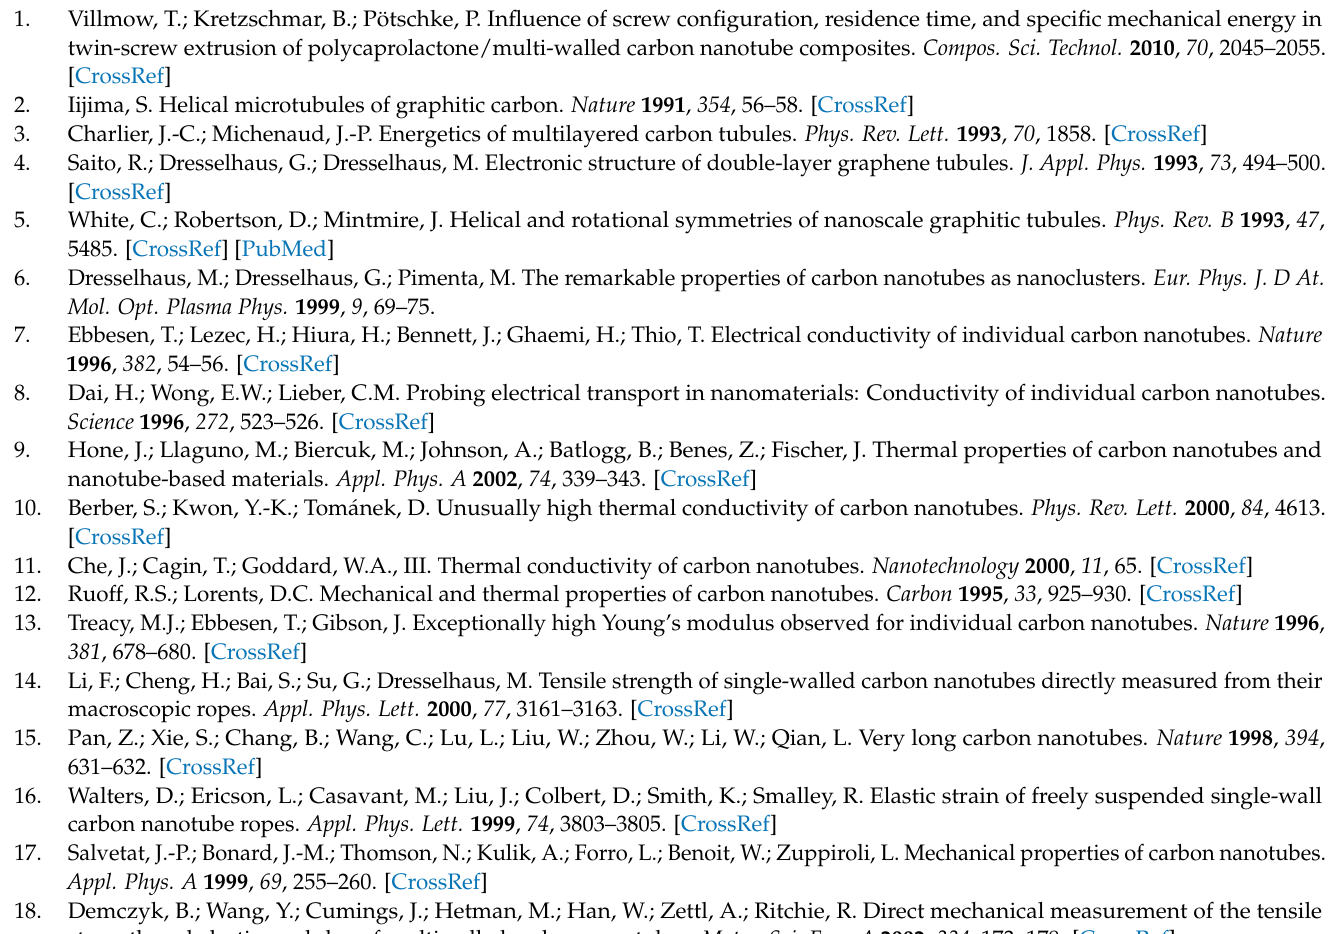
Figure A6. SEM image of the 4.90 wt.% SWNT/PP composite.